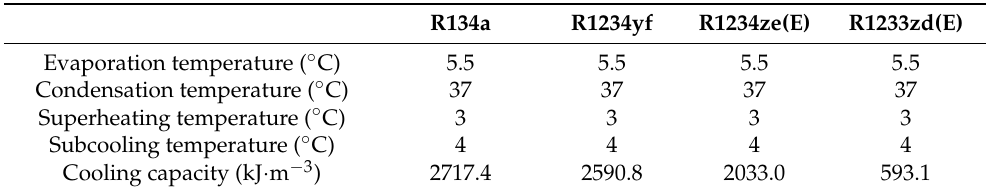
Table 2. Cooling capacity per unit volume of 4 refrigerant